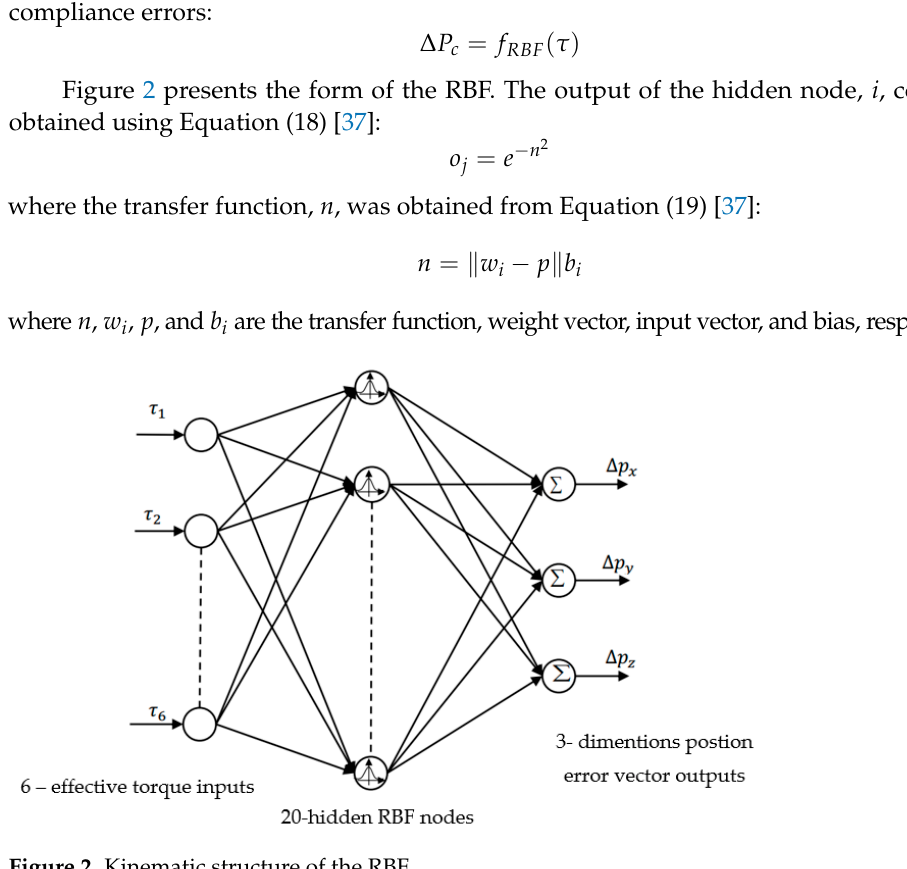
Figure 3. Flowchart of the proposed method. 5. Experiments and Results To perform the calibration process, the experimental study was performed on a six DOF robot manipulator (YS100) carrying a heavy load. An API laser tracker (measure- ment accuracy of 0.01 mm/m, repeatability of ±0.006 mm/m) and an accompanying laser reflector attached to the end-effector of the robot were used for collecting the data. Figure 4 presents the experimental calibration setup.